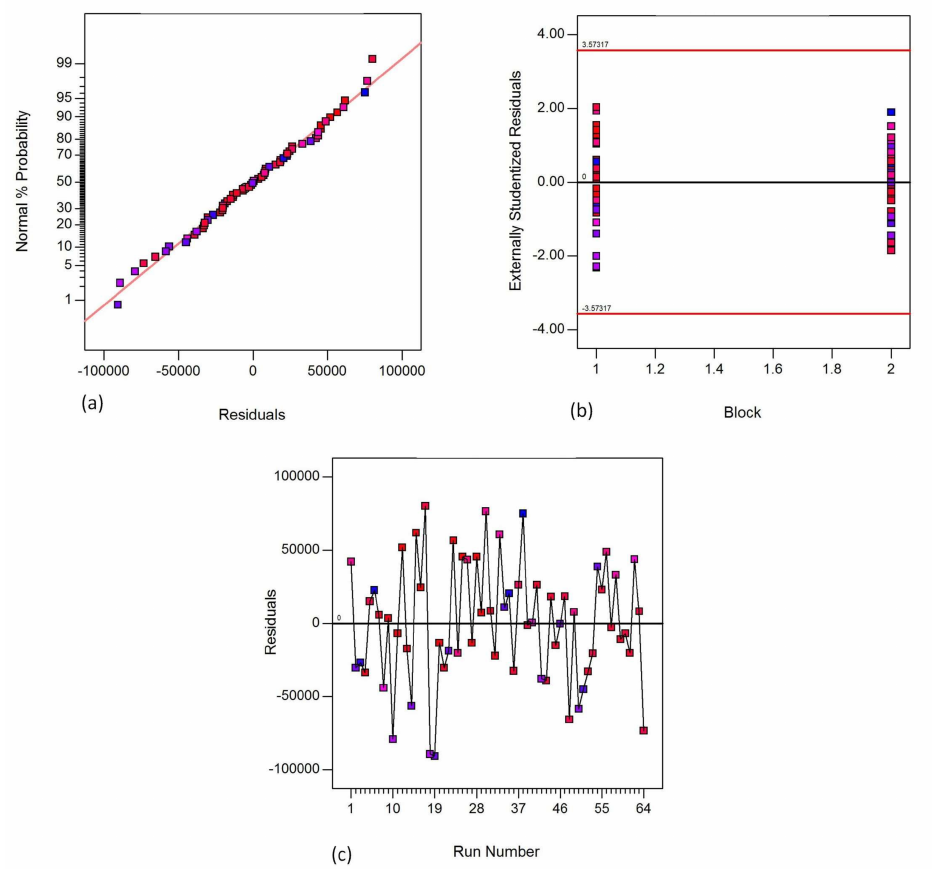
Figure 5. Fisher assumptions ( a ) residual normality; ( b ) equality of variance and ( c ) run-order independence for flexural